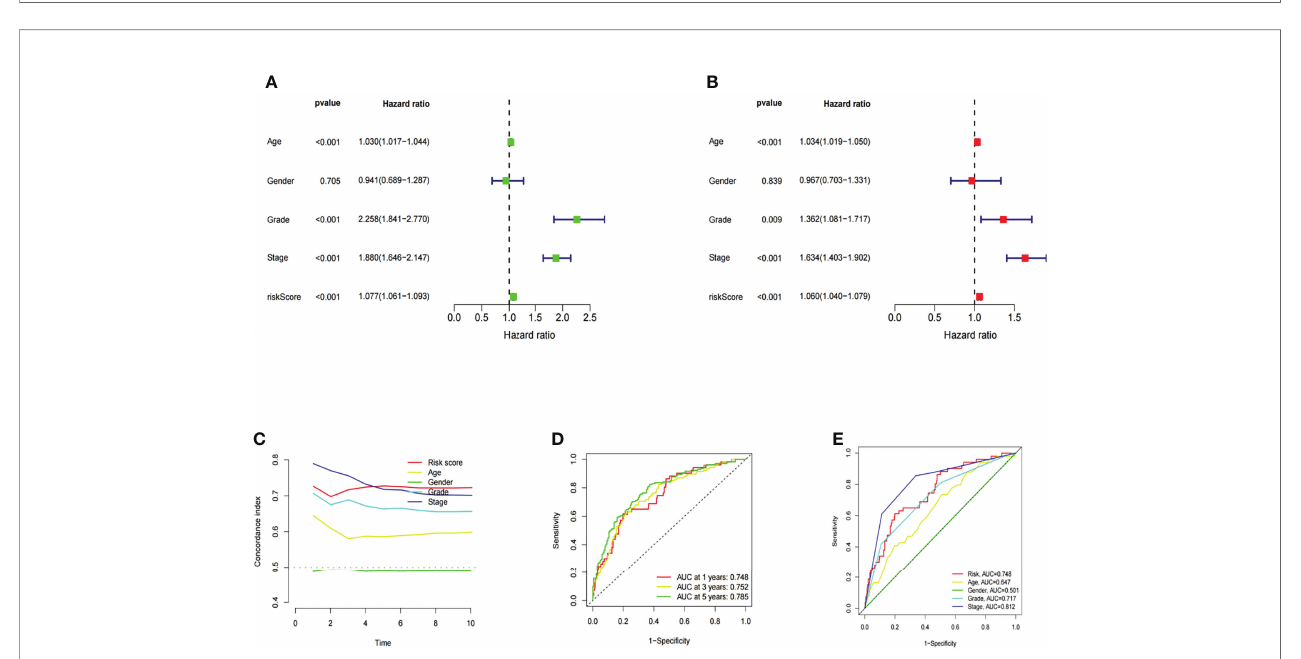
FIGURE 9 | Assessment of the prognostic risk model of the m6A-related lncRNAs and clinical features of KIRC in the entire TCGA set. (A, B) Univariate and Multivariate analyses of the clinical features and risk scores with the OS. (C) Concordance indexes of the risk scores and clinical features. (D, E) ROC curves of the clinical features and risk